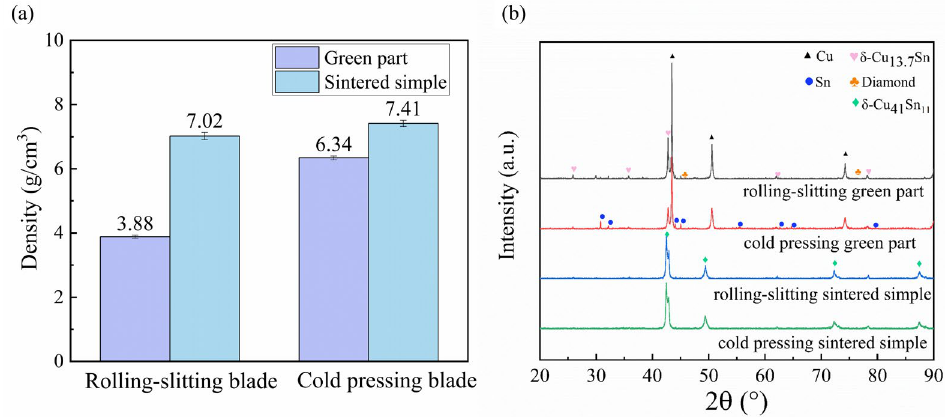
Figure 5. Density and phase composition of green and sintered samples with different forming methods: ( a ) Density; ( b ) Phase methods: ( a ) Density; ( b ) Phase composition.